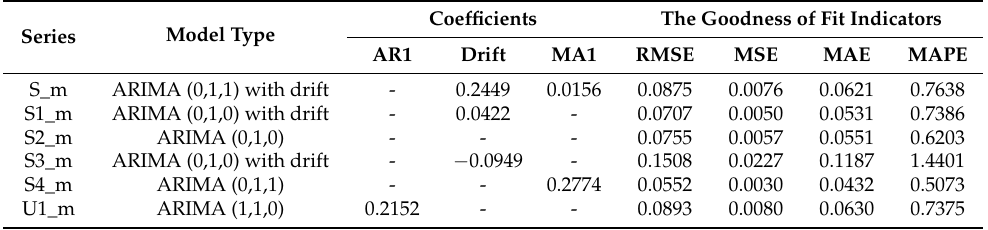
Figure 5. The monthly differentiated series. The best ARIMA models for the monthly series are presented in Table 16. For S1_m, S2_m, and S3_m, they are the differentiated series with or without drift. The models for S_m and S4_m are ARIMA, for which the autoregressive part is missing; for U1_m, it is an ARIMA whose moving average part is absent. Table 16. ARIMA models for the monthly series and